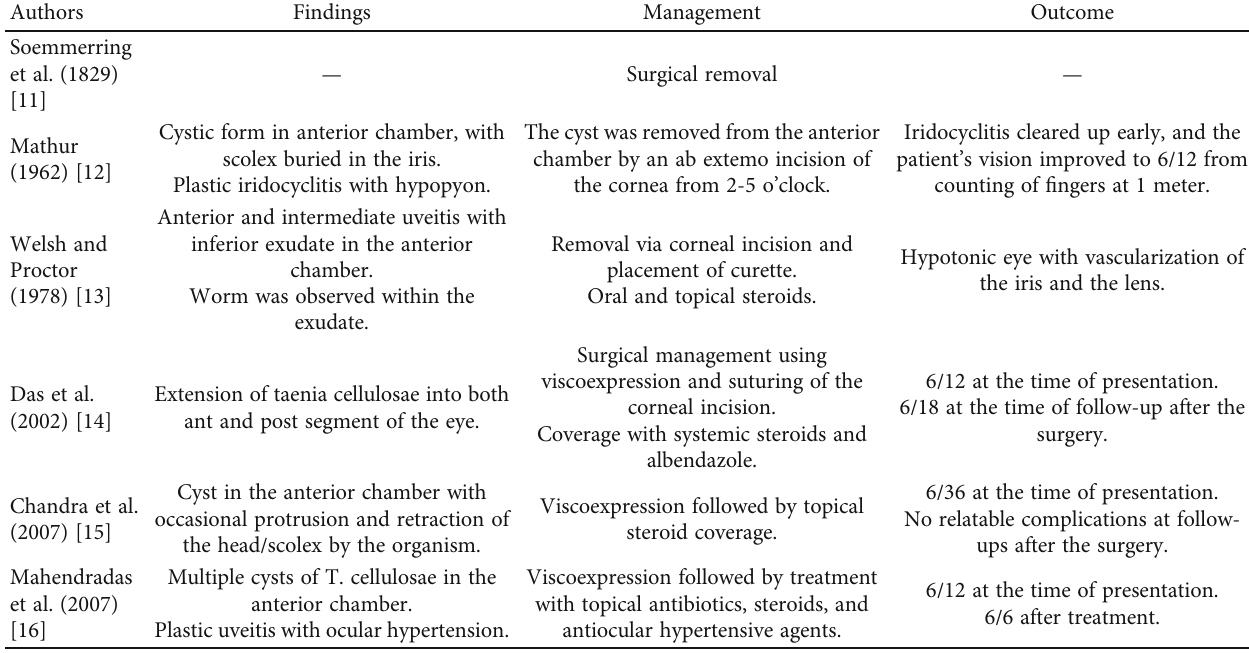
Table 1: Review of relevant published articles on anterior segment cysticercosis along with their common fi ndings, management, and